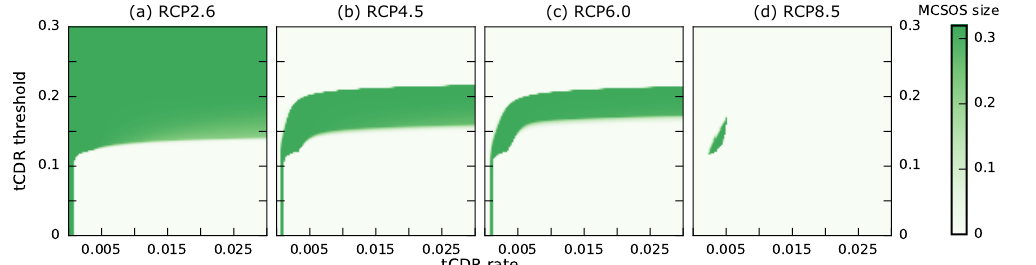
Figure 8. Relative size of the MCSOS for normalised parameter variation of potential maximum tCDR rate ( x axis) and tCDR threshold ( y axis) for different underlying emission scenarios: (a) RCP2.6 ( c max = 0 . 2), (b) RCP4.5 ( c max = 0 . 31), (c) RCP6.0 ( c max = 0 . 36) and (d) RCP8.5 ( c max = 0 .